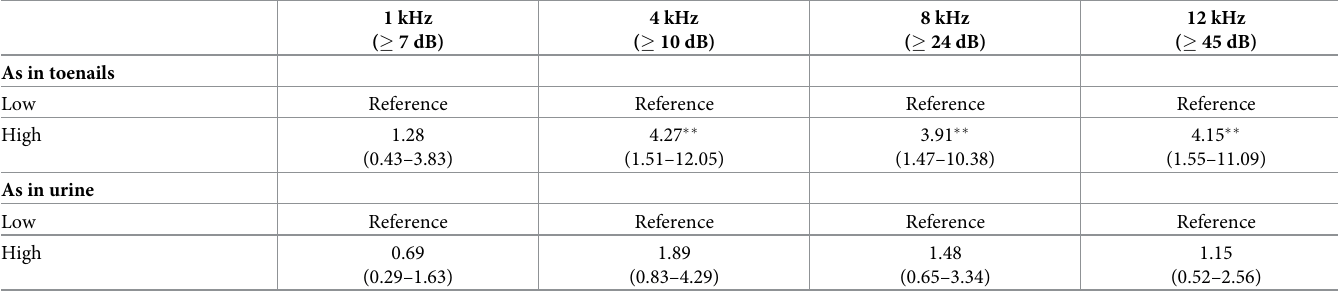
Table 4. Adjusted ORs (95% CI) for hearing loss and As levels in biological samples (n = 145) a